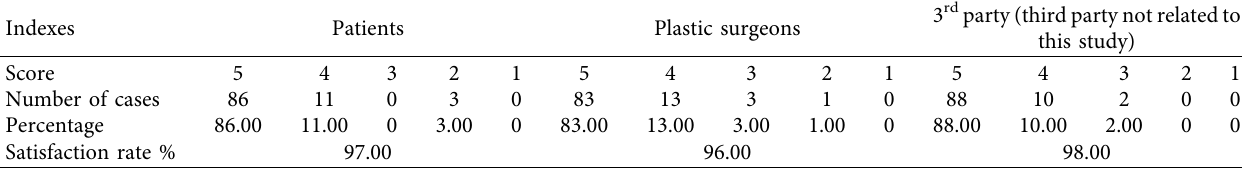
Table 2: Satisfaction evaluation of patients, plastic surgeons, and third parties 6 months after surgery.